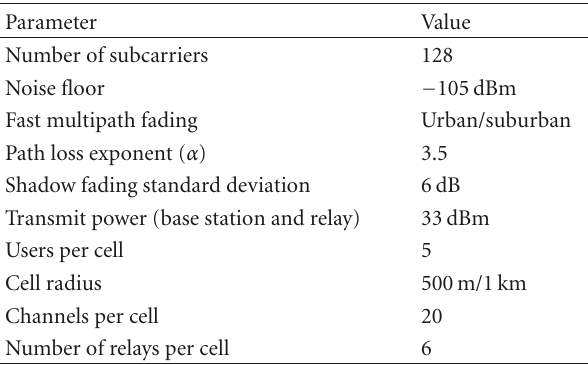
Table 1: Simulation parameters.